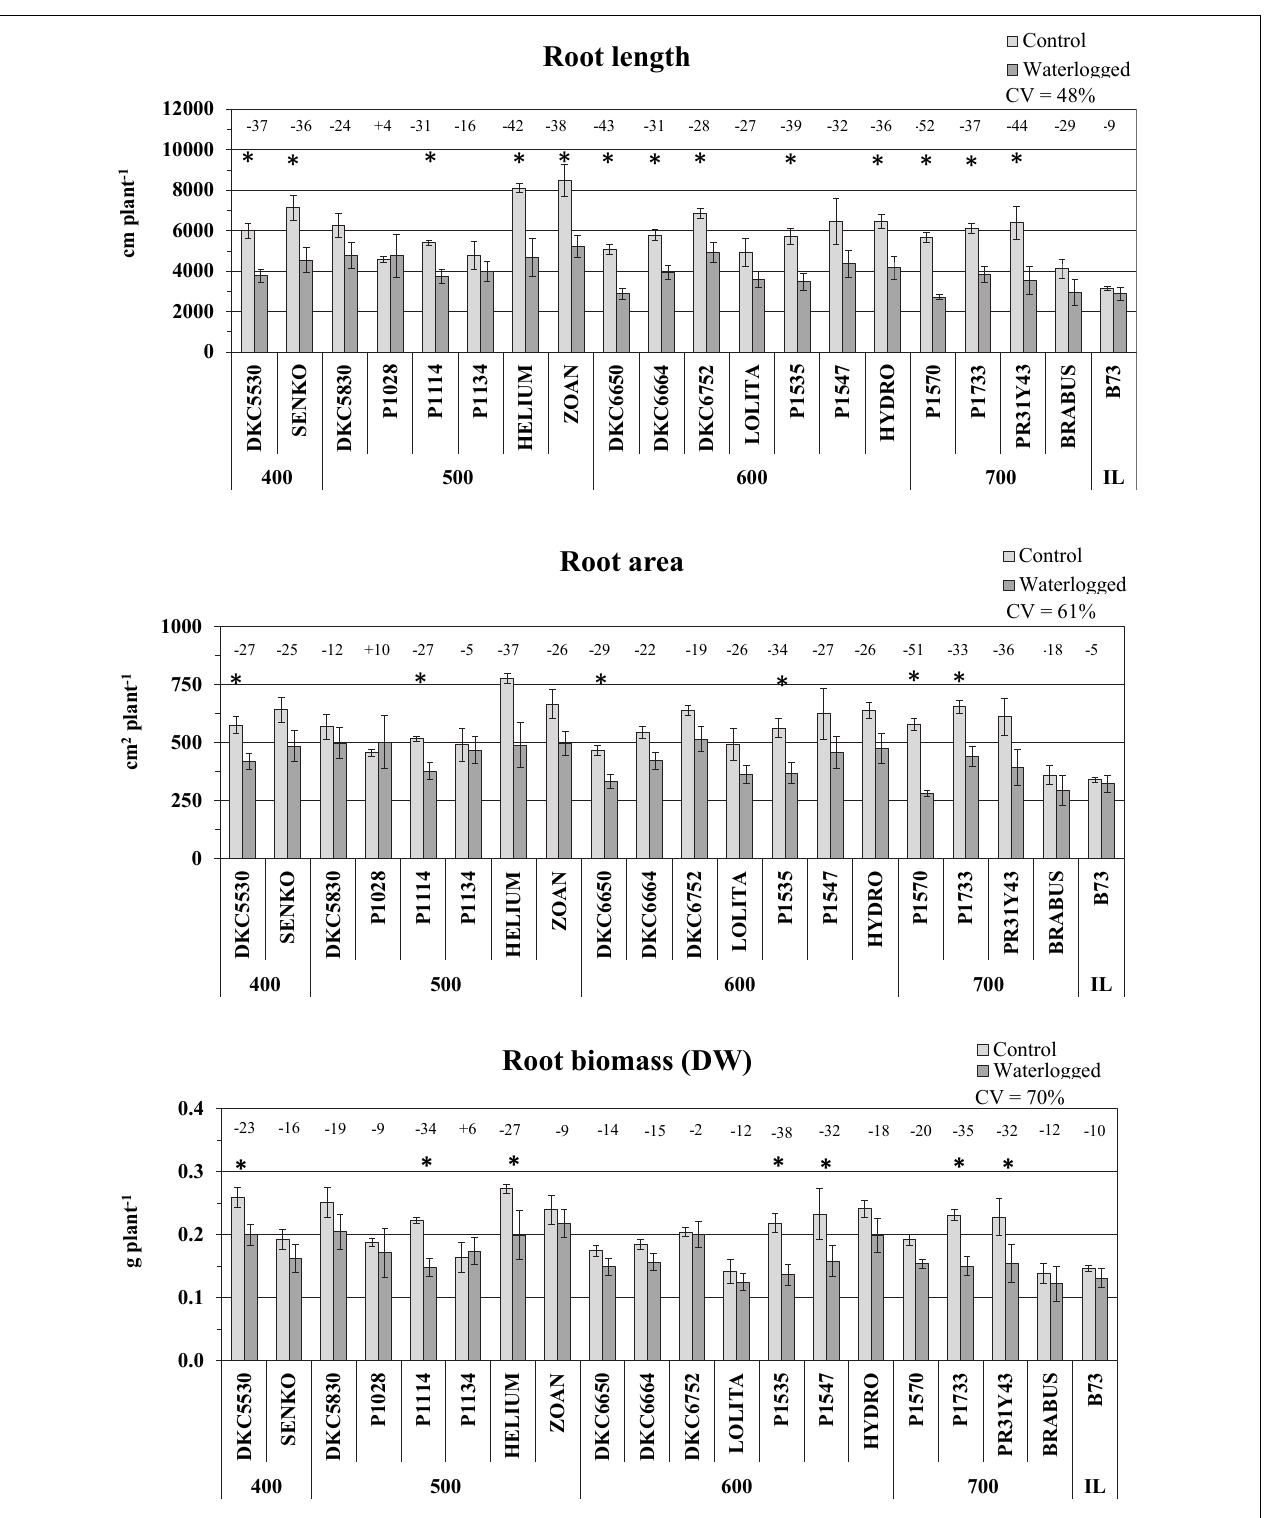
FIGURE 4 | Root length (average ± SE; n = 3), area (average ± SE; n = 3), and biomass (average ± SE; n = 3) of control and waterlogged plants of commercial hybrids and the inbred line B73 at 17 DAS, grouped according to FAO class of maturity (from 400 to 700). Numbers above histograms indicate the percentage variation between waterlogged plants and controls for each hybrid, with asterisks indicating significance ( P ≤ 0.05).